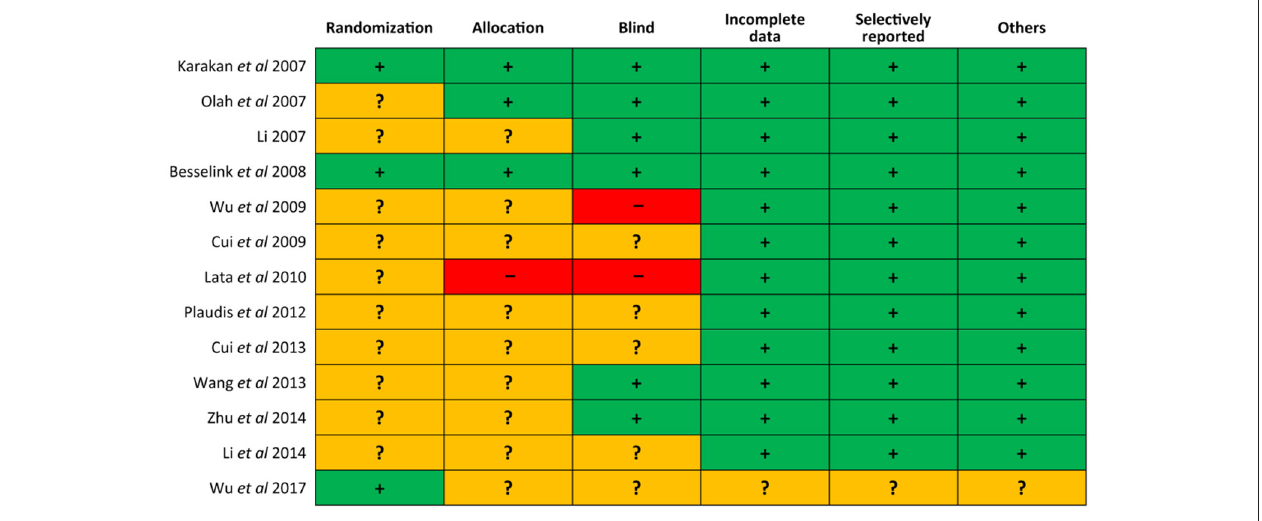
FIGURE 2 | Risk of bias of all 13 eligible